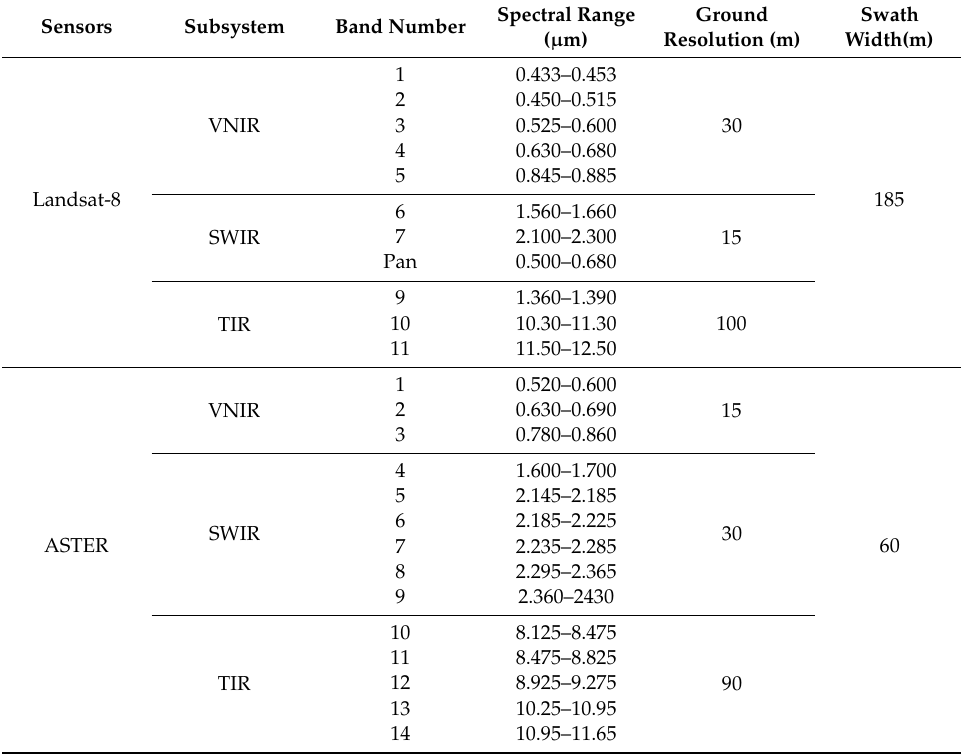
Table 1. Technical characteristics of the Landsat-8, Advanced Spaceborne Thermal Emission